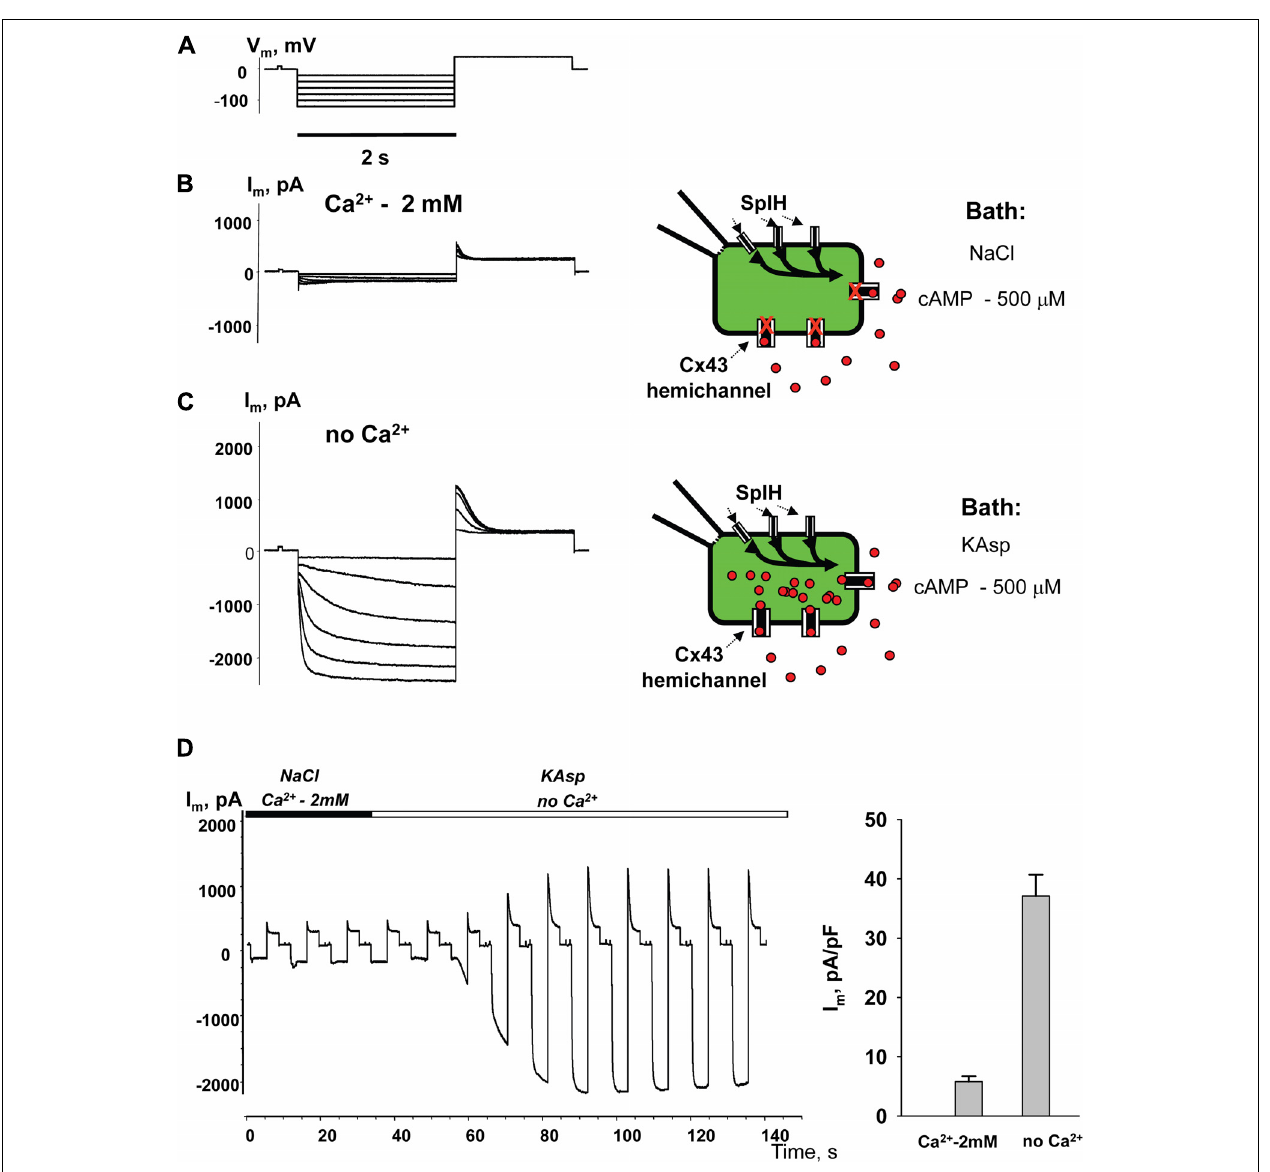
potential of + 50 mV. Over time, perfusion with the Ca 2 + -free KAsp external solution induced a SpIH current increase to a steady-state. (E) Average of current densities measured in the presence of external Ca 2 + and after perfusion with the KAsp solution with no Ca 2 + : 5.8 ± 0.9 pA/pF versus 37.1 ± 3.6, n = 7, P < 0.001, t -test. 500 μ M cAMP was present in the external solution at any time during the